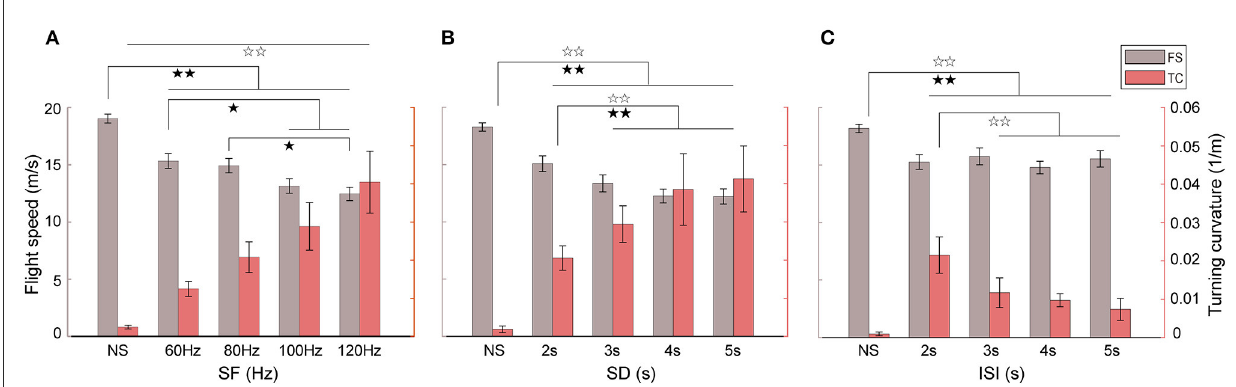
FIGURE5 Effects of stimulus parameter variations on the turning speed and curvature of robo-pigeons. (A) With different stimulus frequencies; (B) with different stimulus duration; (C) with different inter-stimulus intervals; NS denotes the non-stimulus segment before turning flight; SF, stimulus frequency; SD, stimulus duration; ISI, interstimulus interval; FS, flight speed; TC, turning curvature. Black stars indicate significant differences in the flight speed, and blank stars significant differences in the turning curvature, respectively ( * p < 0.05, ** p <